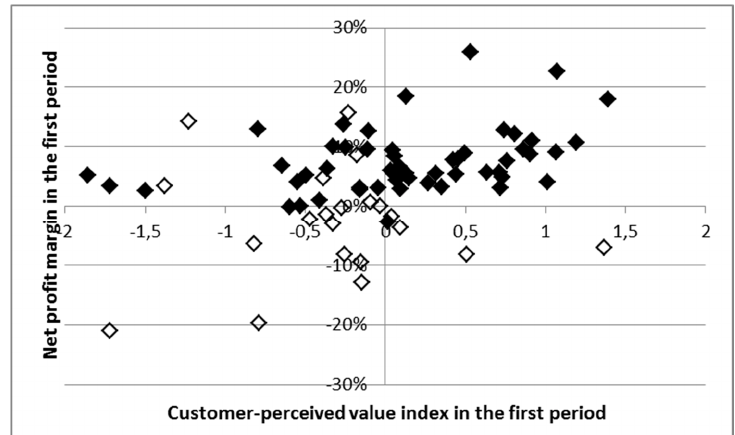
Figure 2. Net profit margin and customer-perceived value index in the first period (ca. 2006–2009). Filled (black) symbols represent contractors that still worked for the customer, whereas unfilled symbols represent contractors that ceased to work for the customer.